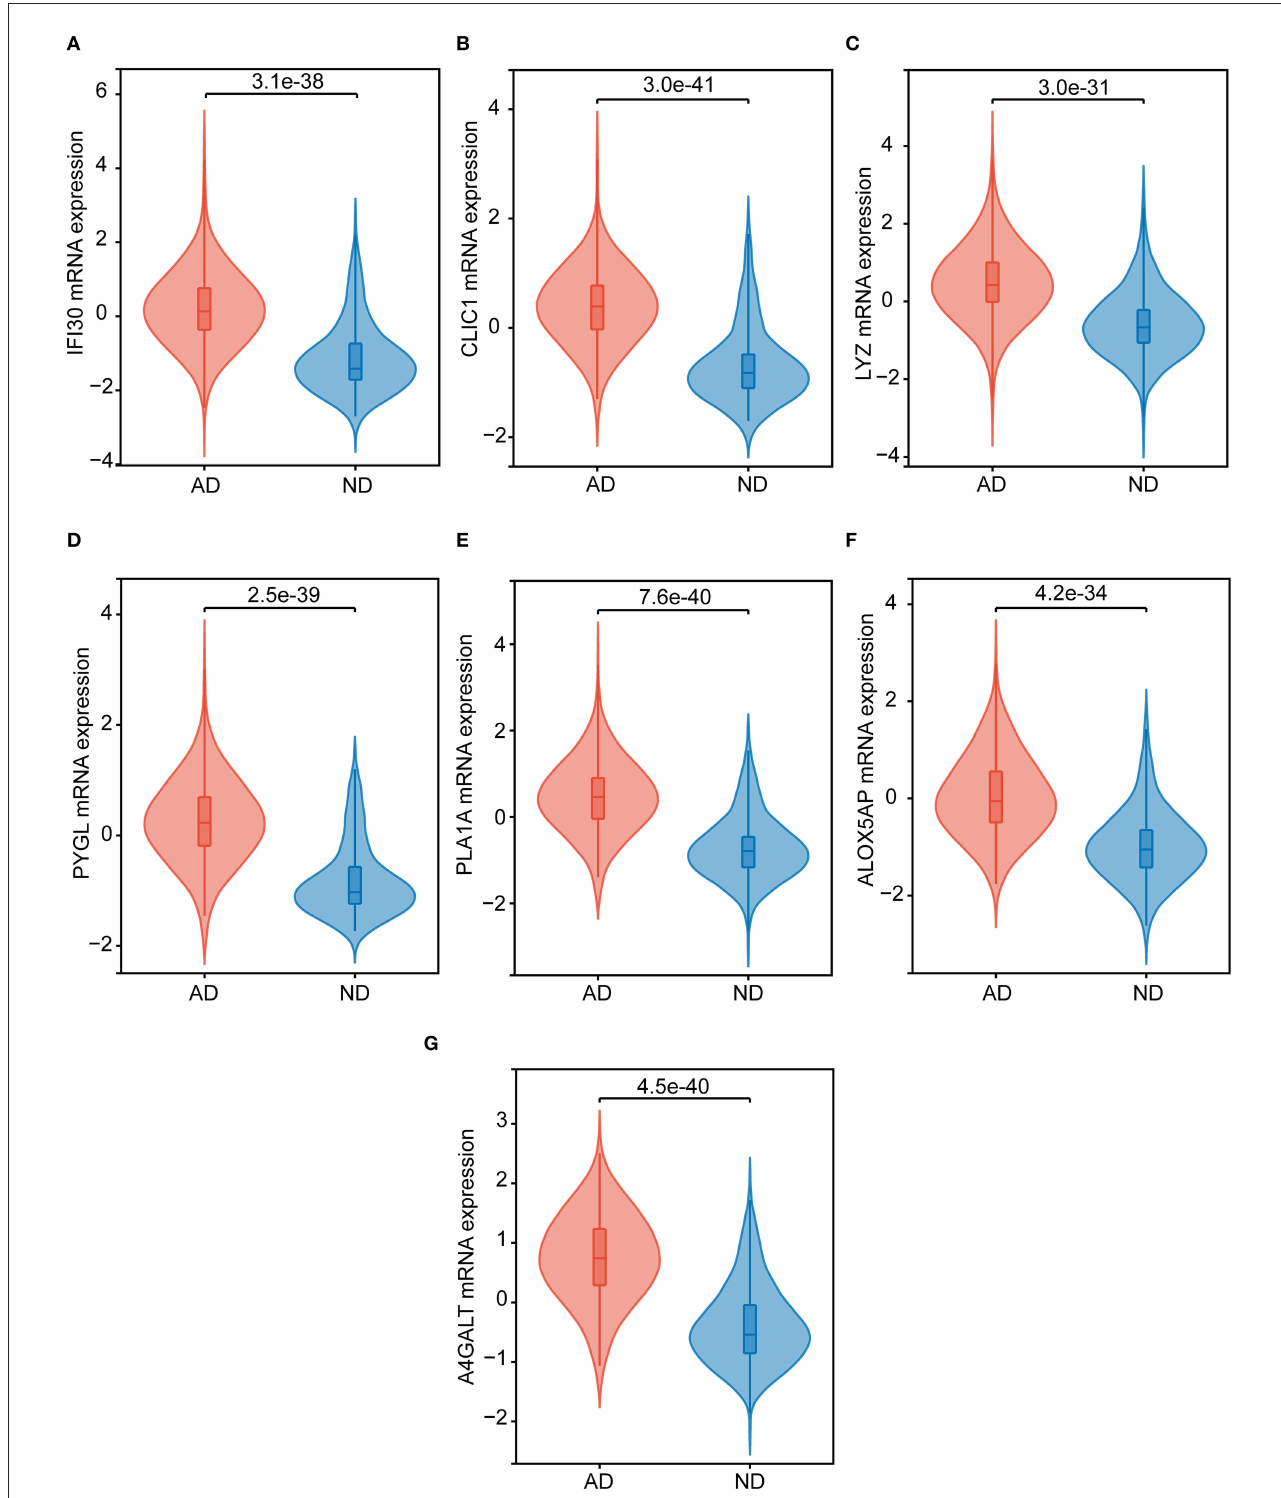
FIGURE5 The hub genes expression in the ND and AD samples of GSE33000. (A) IFI30, (B) CLIC1, (C) LYZ, (D) PYGL, (E) PLA1A, (F) ALOX5AP, and (G) A4GALT.